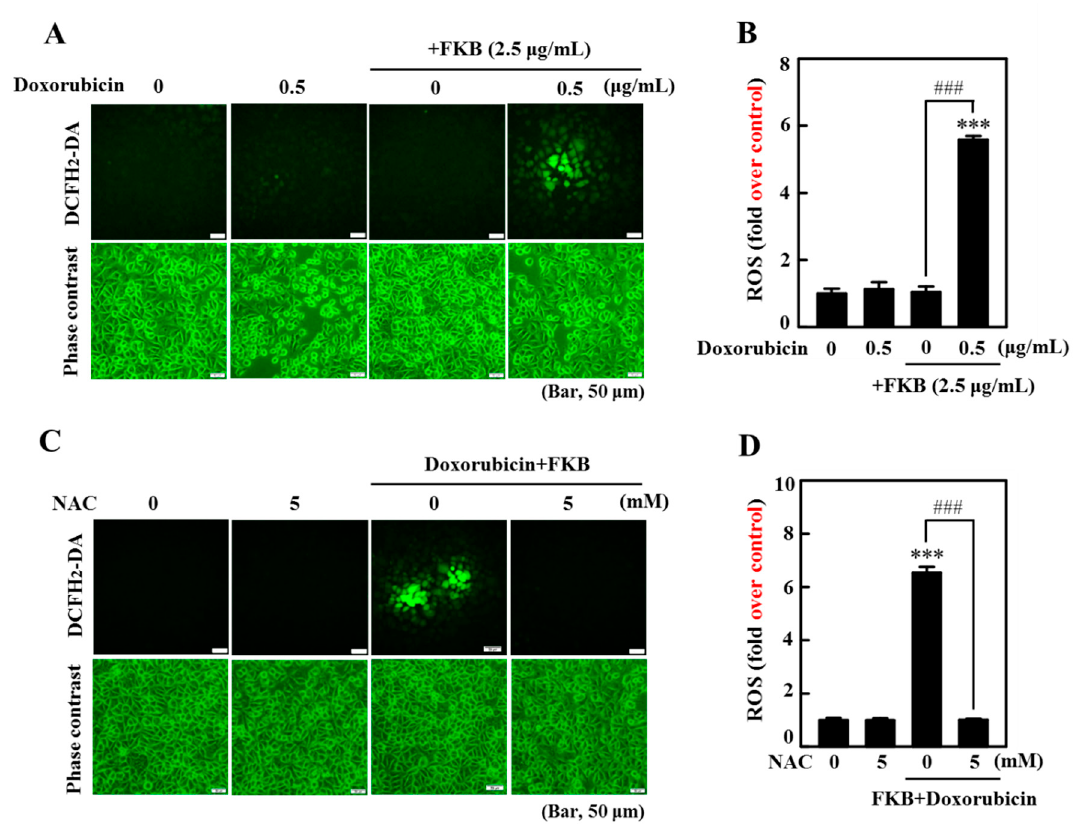
Figure 9. ROS generation in AGS cells was induced by FKB + doxorubicin. ( A , B ) FKB exacerbates intracellular ROS generation triggered with doxorubicin. The generation of ROS was measured at 60 min following co-treatment with FKB (2.5 µ g / mL) and doxorubicin (0.5 µ g / mL). ( C , D ) Antioxidant NAC prevents generation of FKBs and doxorubicin triggered ROS. Cells were pretreated with or without NAC (5 mM, 1 h) followed by exposure to FKB (2.5 µ g / mL) and doxorubicin (0.5 µ g / mL) co-treatment for the indicated time. The DCFH2-DA fluorescence method was used. The DCFH2-DA probe reacts with a cellular ROS and is metabolized into fluorescent DCF. The amount of fluorescent DCF is proportionate to ROS production. The ROS concentrations are depicted as control folds in the graph. Values were expressed as mean ± SD ( n = 3). Significant at *** p < 0.001 compared to untreated control cells. Significant at ### p < 0.001 compared to FKB- or FKB + doxorubicin-treated